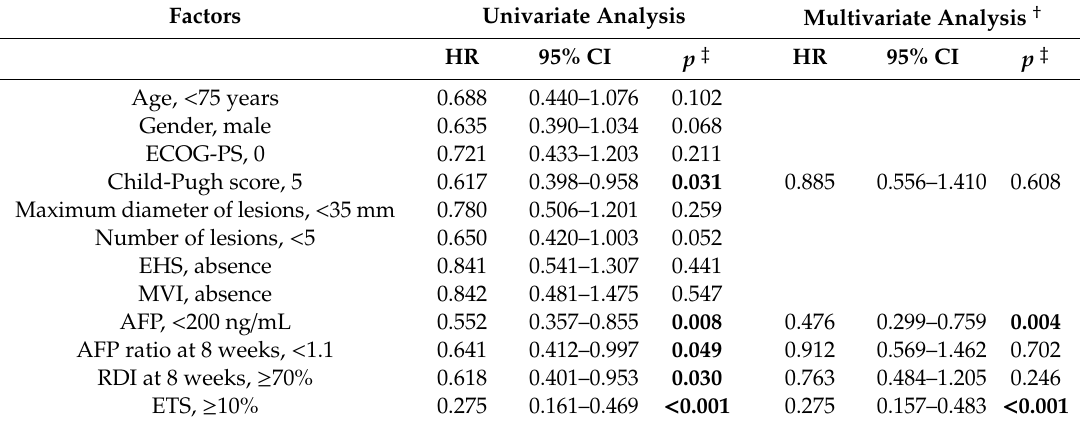
Table 3. Univariate and multivariate analyses for progression-free